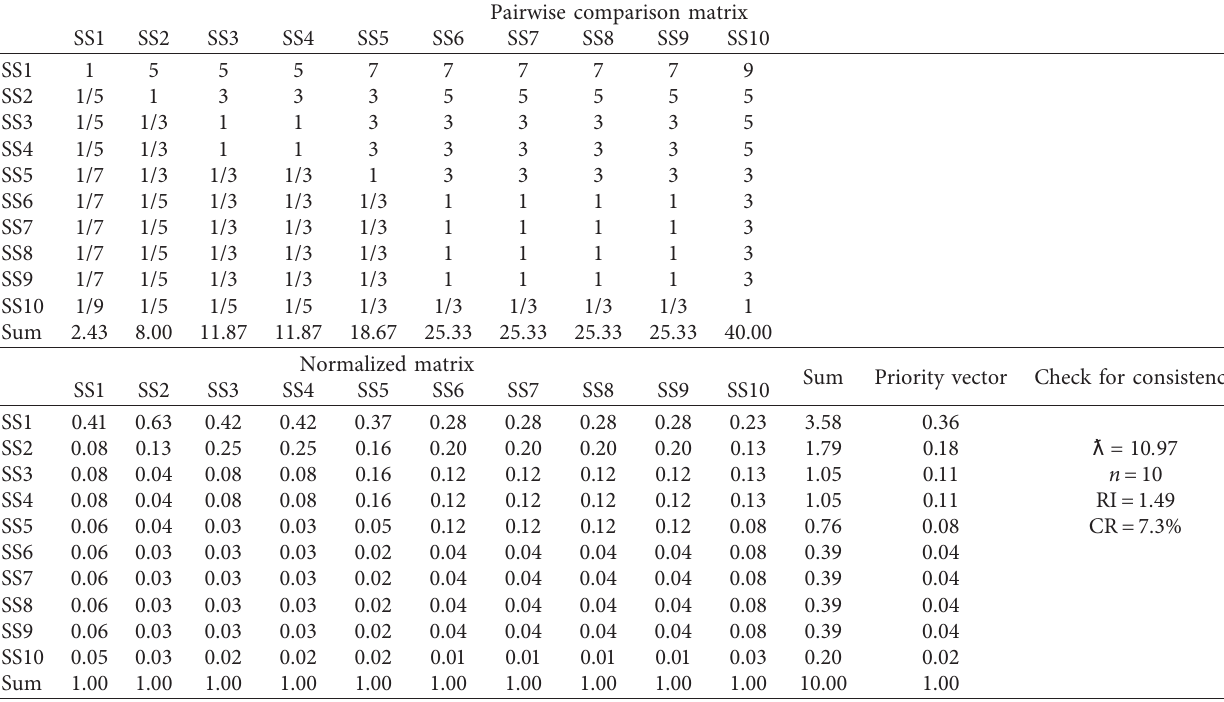
Table 8: Pairwise comparison matrix of criteria with respect to goal.